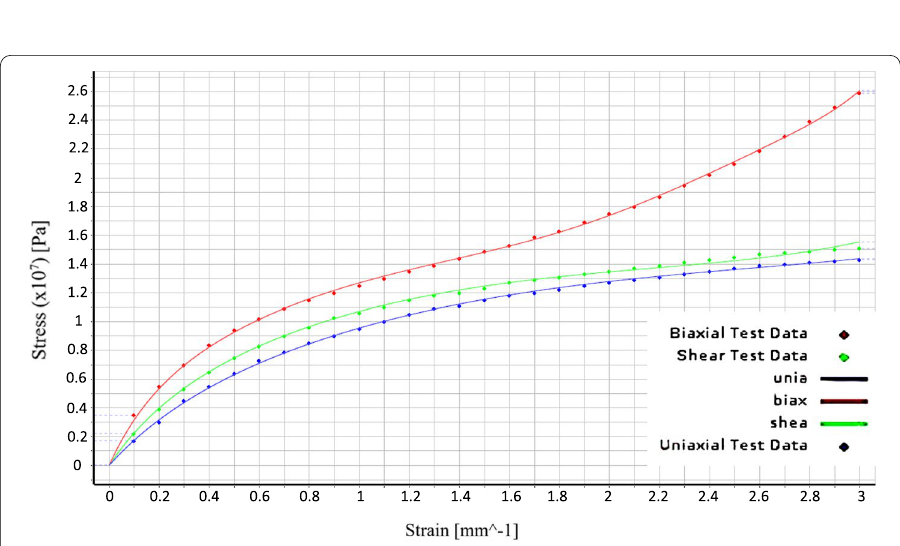
Fig. 6 Synthetic rubber material model for all deformation modes (uniaxial, biaxial, and shear test data) using MR 9 parameter model to evaluate the C ij